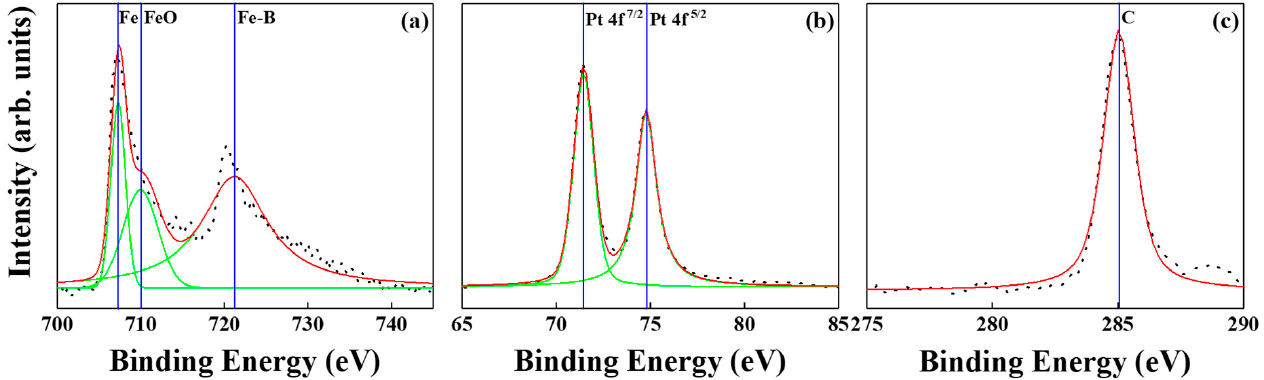
Figure 12. XPS spectra of BN/FePtCAg/MgTiON film, ( a ) the metallic Fe, iron-oxide and iron-boride are indexed, ( b ) Pt and ( c )